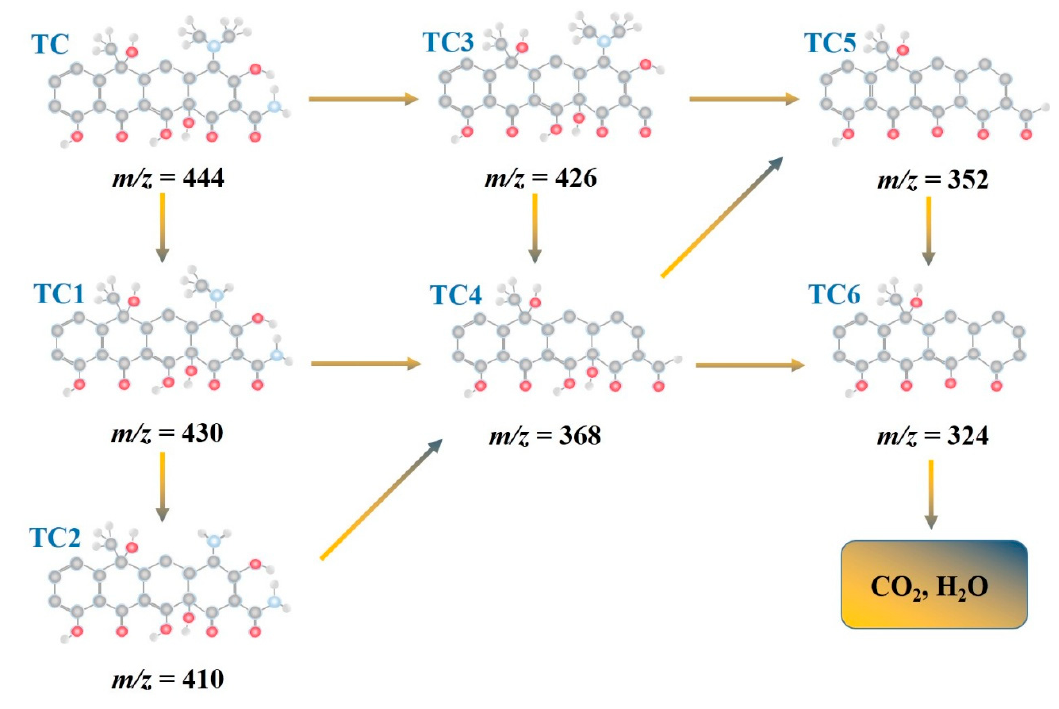
Figure 13. Proposed photocatalytic degradation pathway for TC degradation by CeO 2 QDs/Ag 2 Se.